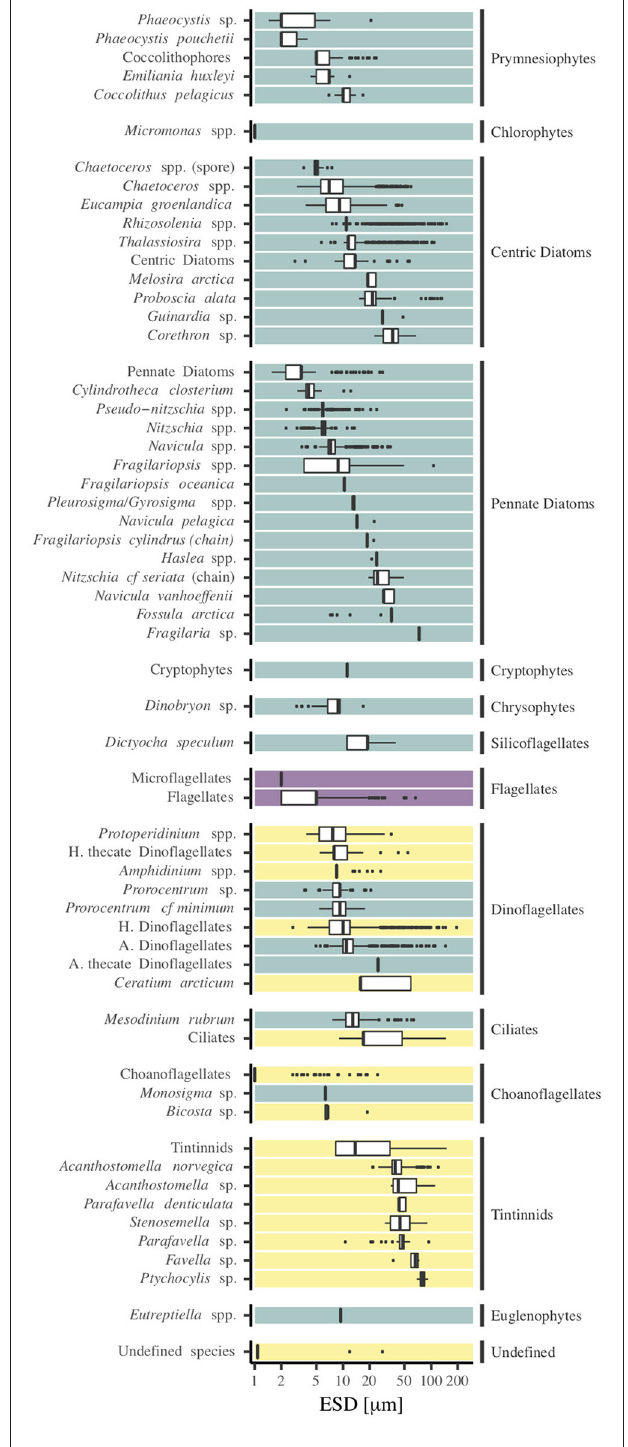
FIGURE 2 | Grouping of all identified species or species groups and their respective size ranges (equivalent spherical diameter (ESD) in µ m) on a logarithmic scale. Turquoise species are autotrophic (A.), yellow species are heterotrophic (H.). For purple species, a clear distinction was not possible (in average 10.4% of the total cell concentration), therefore 50% of the cells were treated as autotrophic, and 50% as